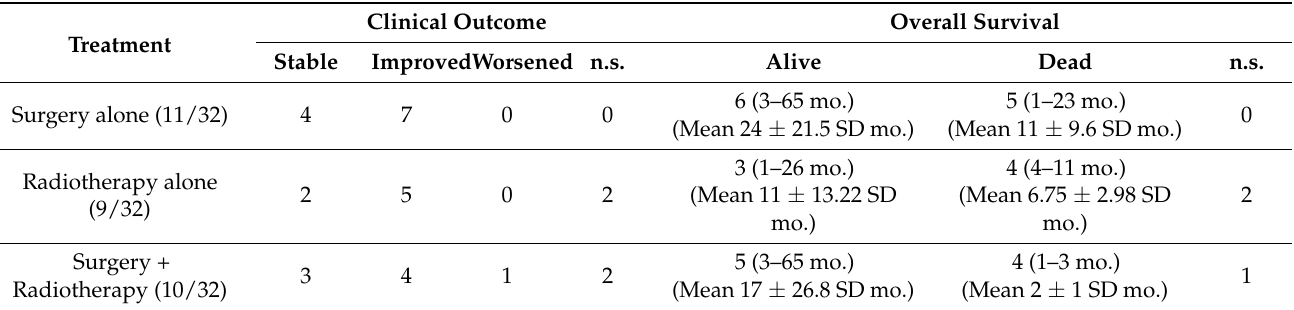
Table 5. Outcome and overall survival data according to the treatment in 32 intramedullary spinal cord metastases from